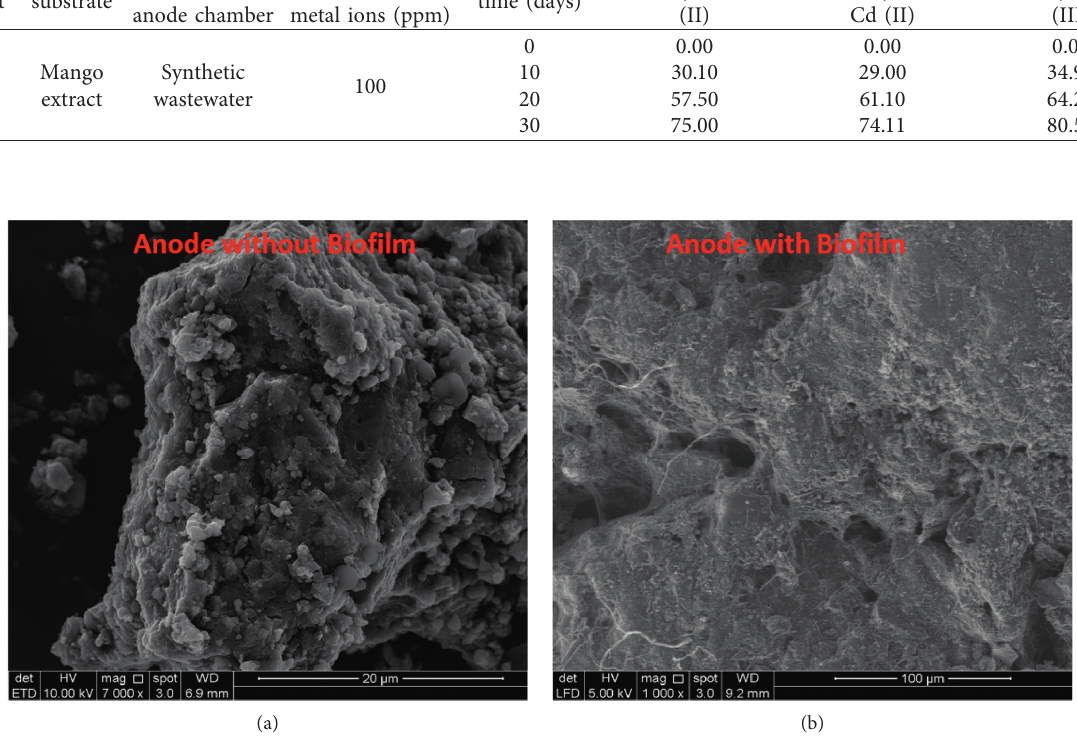
Figure 4: SEM images of (a) anode electrode without biofilms and (b) anode electrode with biofilms.